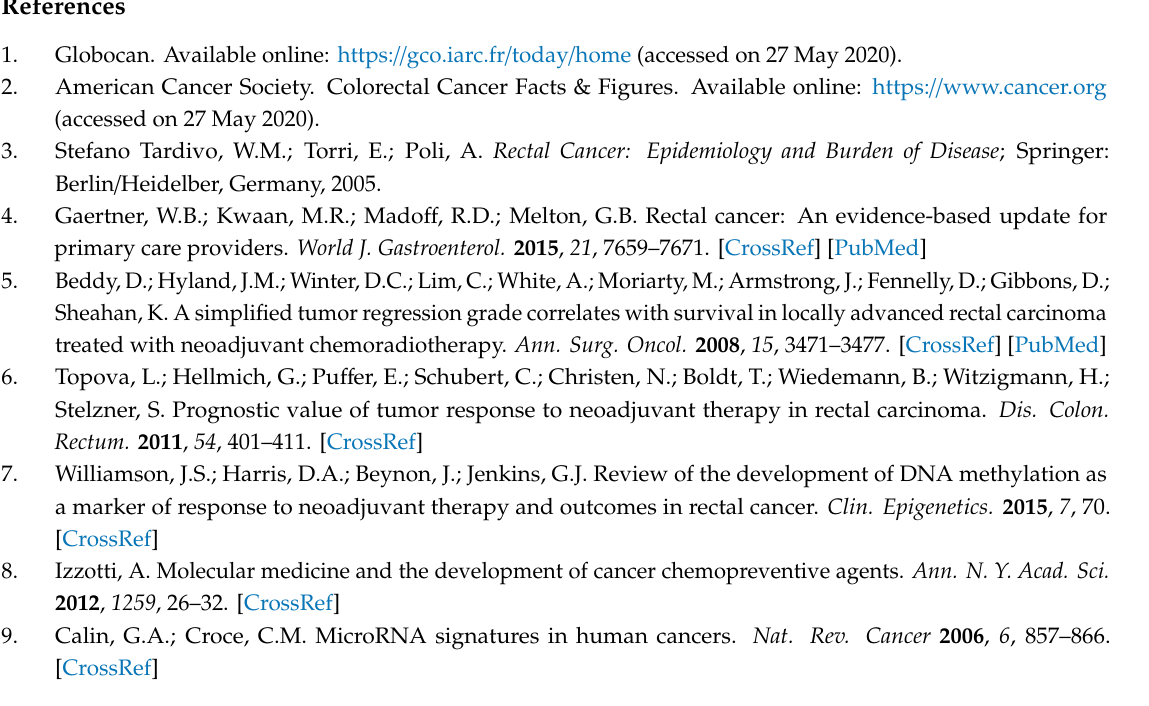
Table S1: Overview of the full review strategy with search strings. Table S2: List of mRNAs di ff erentially expressed in responders versus non responders. Table S3: List of miRNAs di ff erentially expressed in responders versus non